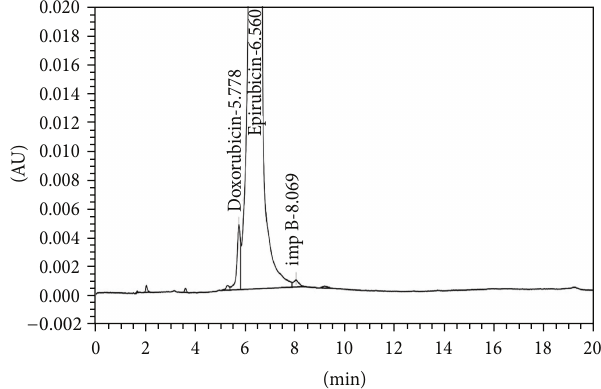
Figure 10: HPLC profile of unirradiated doxorubicin.